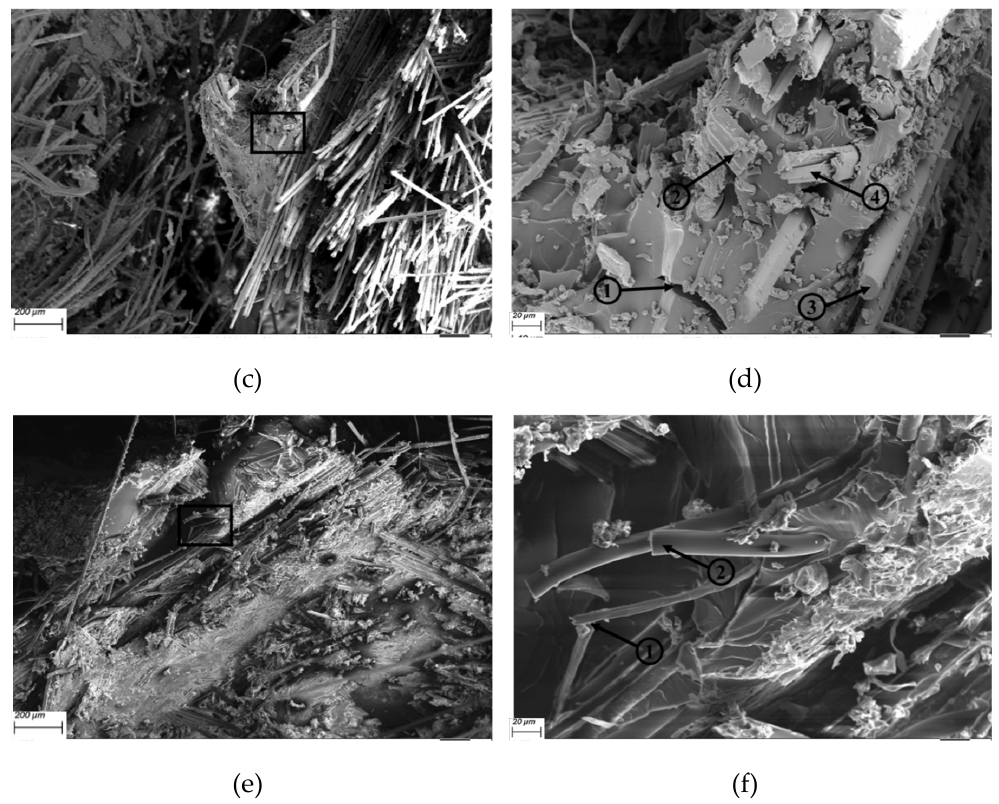
Figure 14. SEM images of flax/VE/basalt hybrid composites: ( a ) 150× magnification with 50 J, ( b ) 1000× magnification with 50 J, ( c ) 150× magnification with 60 J, ( d ) 1000× magnification with 60 J, ( e ) 150× magnification with 70 J, and ( f ) 1000× magnification with 70 J.